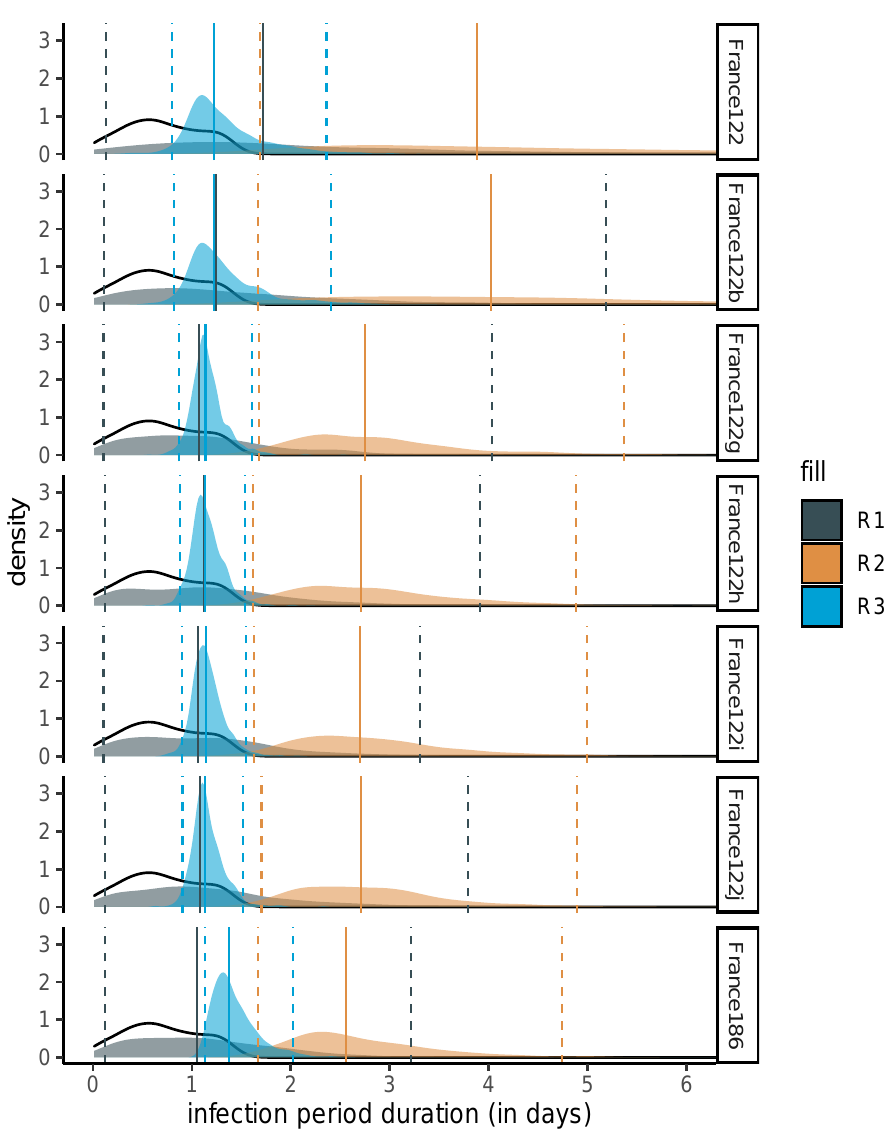
Figure S10 – Reproduction numbers for the France186 dataset and subsets with 122 sequences. Here we assume BDSKY model. The thick line shows the prior distribution. For , posterior distributions are close to the prior (black dashed line) indicated limited R 1 inference